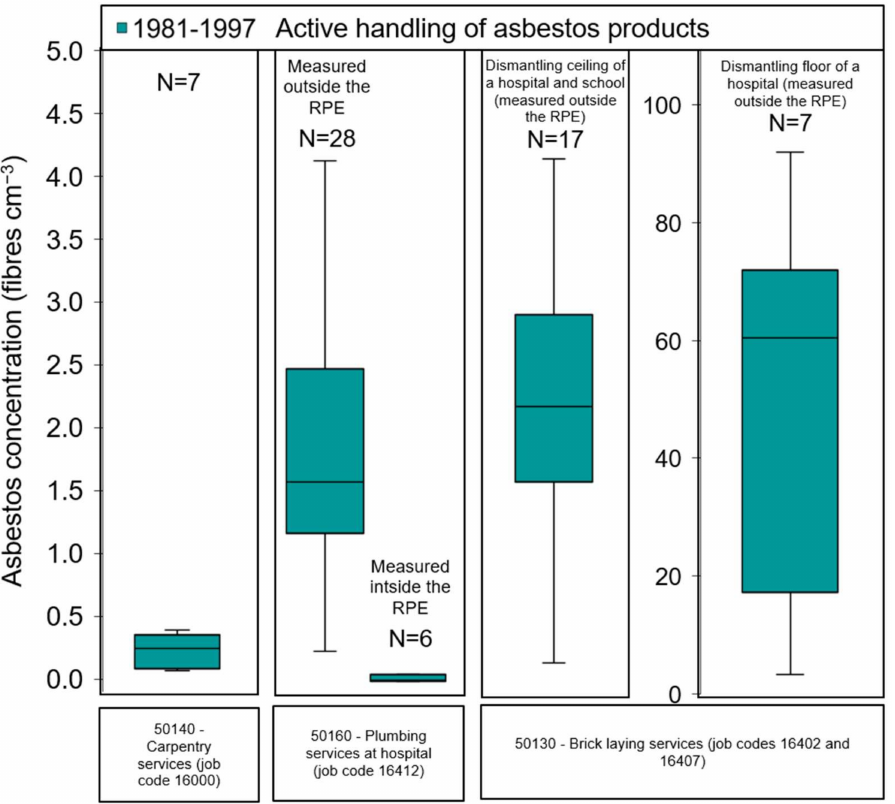
Figure 2. Vertical box plots for the measured personal exposure asbestos concentrations (with N ≥ 4) without respiratory protective equipment being used by the worker (unless specified) during active handling of asbestos products in each industry code for the period 1981–1997. The lower and upper limits of the box plots represent the 25th and 75th percentiles, and the line within the box marks the median. Whiskers (error bars) above and below the box indicate the maximum and the minimum fibre concentration, respectively. N: total number of measurements